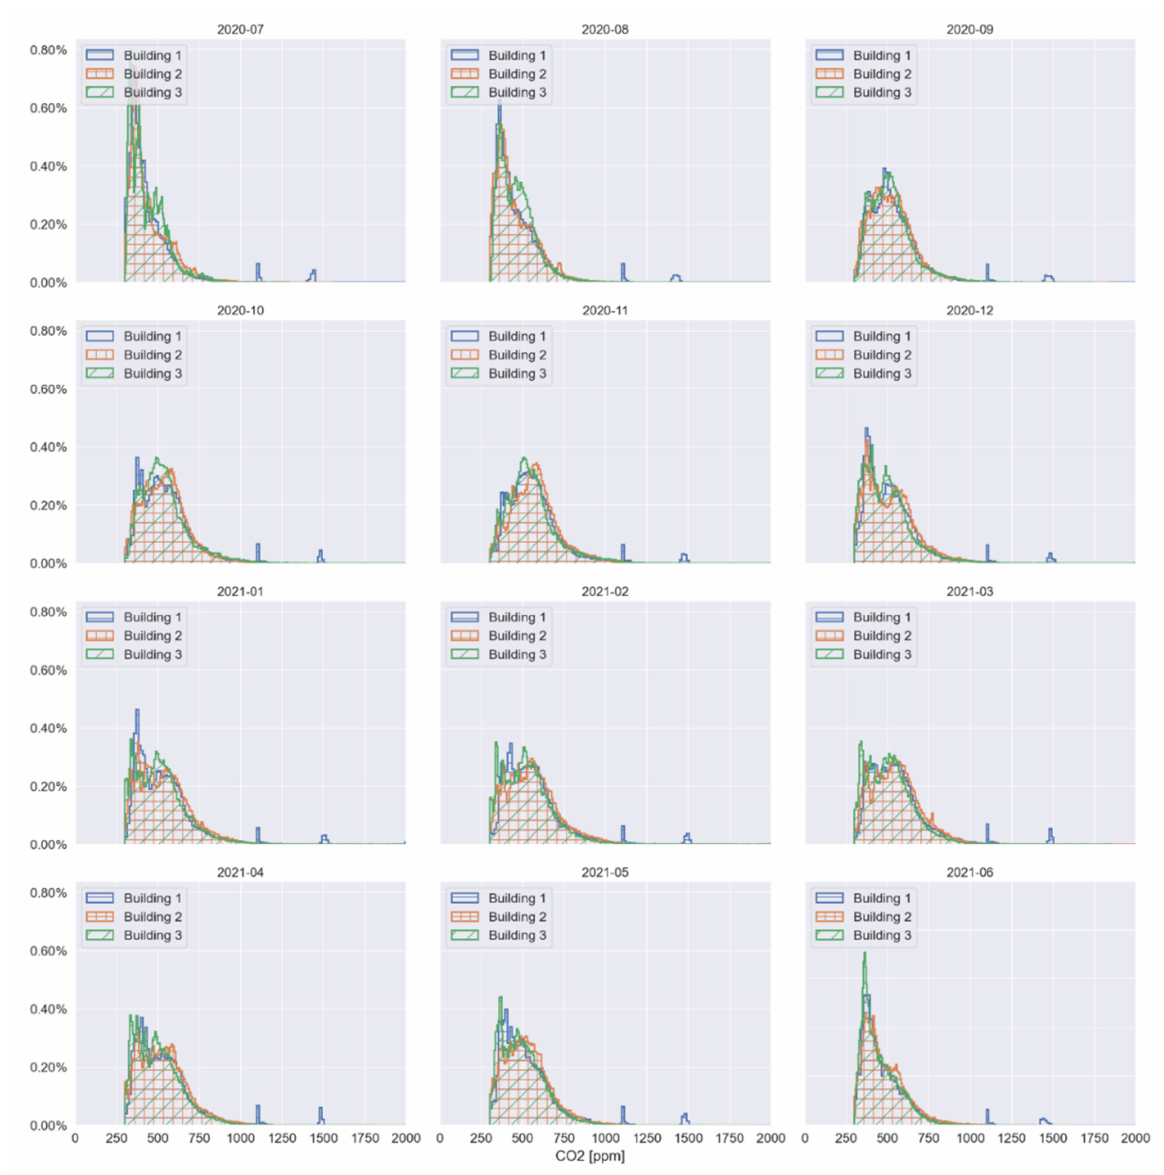
Figure 33. Probability density of hourly values of CO 2 concentration from all the apartments grouped by